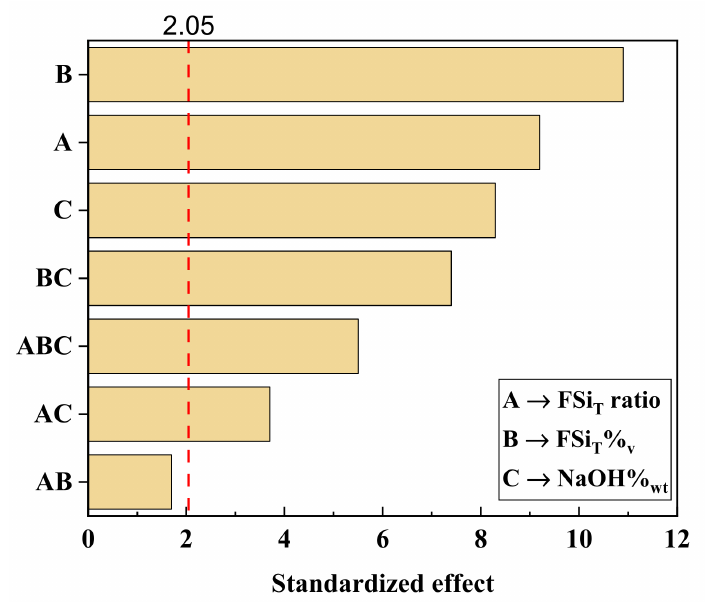
Figure 3. Pareto diagram of the standardised effects of the factors analysed in the 3 3 complete factorial design. The dashed red line represents the critical standardised effect for a significance level of